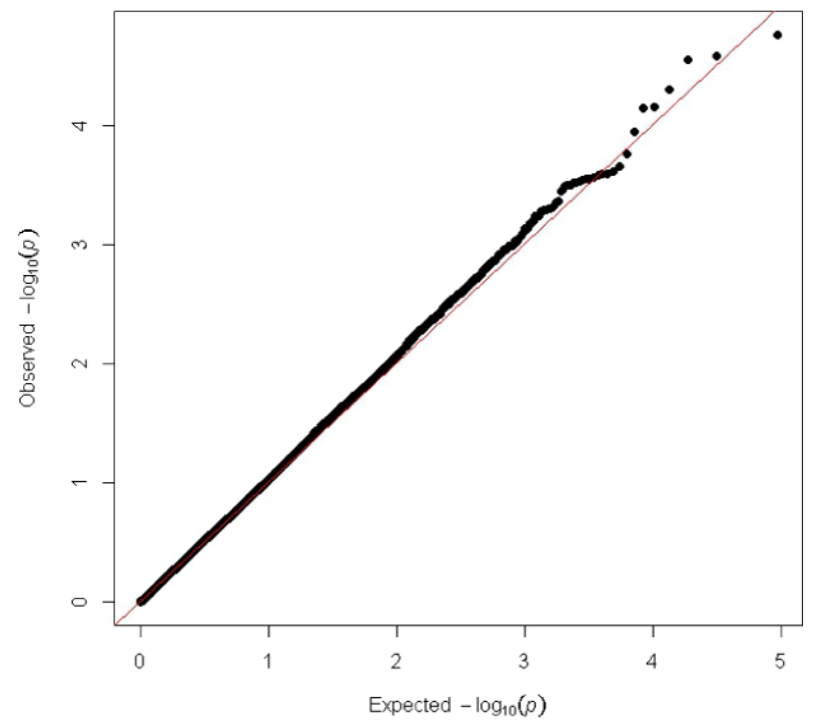
Figure 3. Quantile-Quantile plot for MCHC conditioned on Genome-Wide Significant and Suggestive SNPs. Quantile-quantile plot from association with MCHC, where the red line shows the expected distribution. Representative data from the all-breeds, genotypic mode of inheritance analysis is shown with the top 15 associated SNPs (by nominal P -value) are accounted for as fixed genotypic covariates in the statistical model. The results show very little evidence of population stratification once the top SNPs are accounted for in the model.